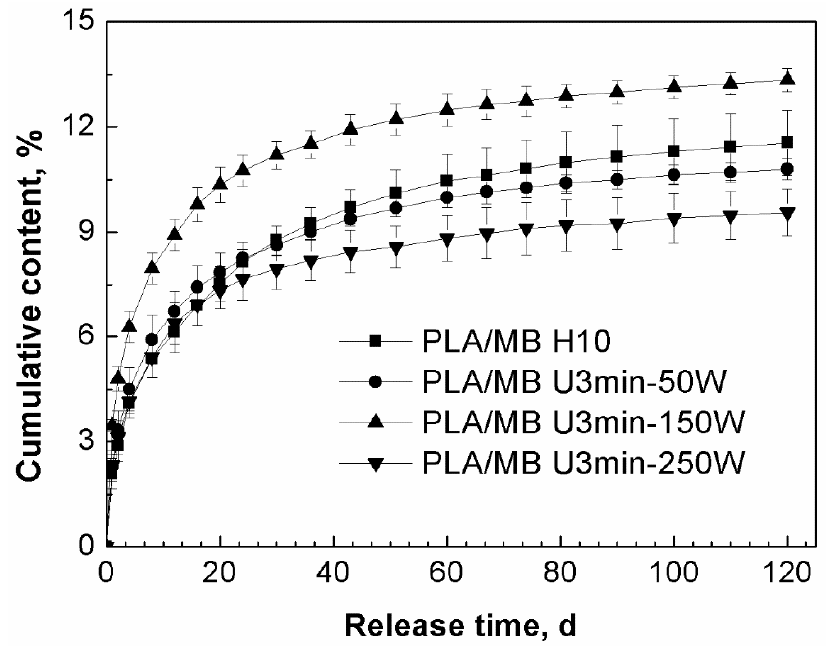
Figure 2. Effect of ultrasound on the release behavior of MB from PLA by immersion in phosphate buffered saline (PBS) for up to 120 days (PLA/ MB H10: without ultrasound treatment, PLA/MB U3 min-50 W: treated by 50 W ultrasound for 3 minutes, PLA/MB U3 min-150 W: treated by 150 W ultrasound for 3 minutes, PLA/MB U3 min-250 W: treated by 250 W ultrasound for 3 minutes).